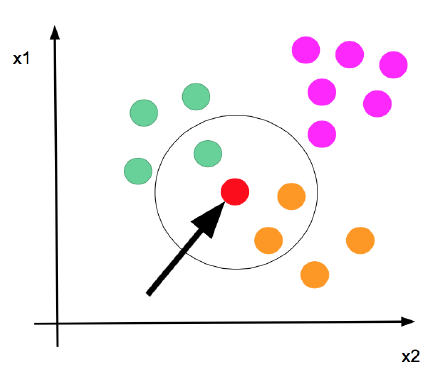
Figure 10. An example of K-NN